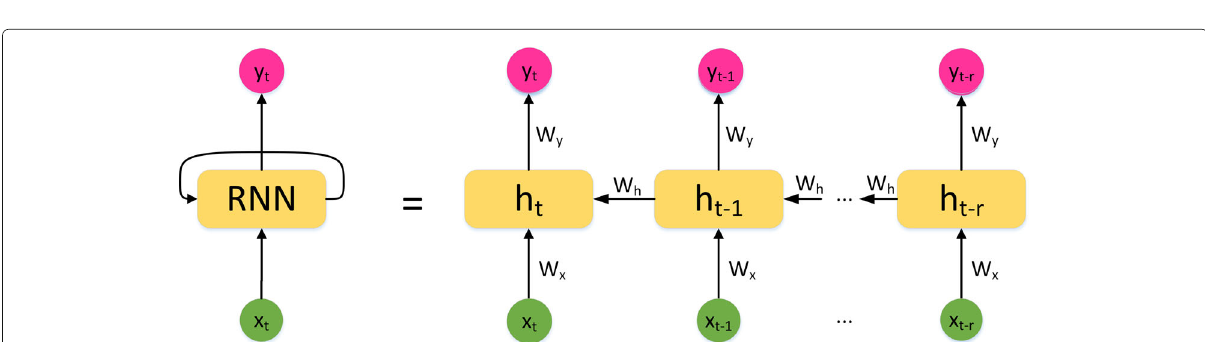
Fig. 1 A standard unfolded RNN structure at time